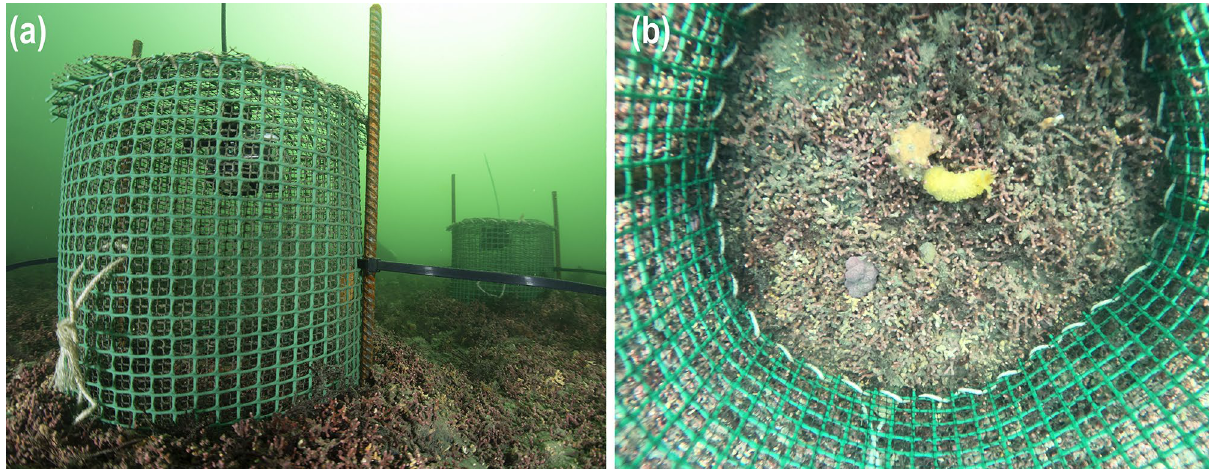
Figure 2. ( a ) In situ experimental setup to determine nudibranch feeding rates on the sponge Hymeniacidon perlevis in the maerl bed of Lomergat (Bay of Brest, France). ( b ) Top-down view of the inside of an incubation cage. The nudibranch Doris verrucosa approaches to eat the sponge H. perlevis after 30 min of incubation. Time lapse of the in situ incubation is available as Video